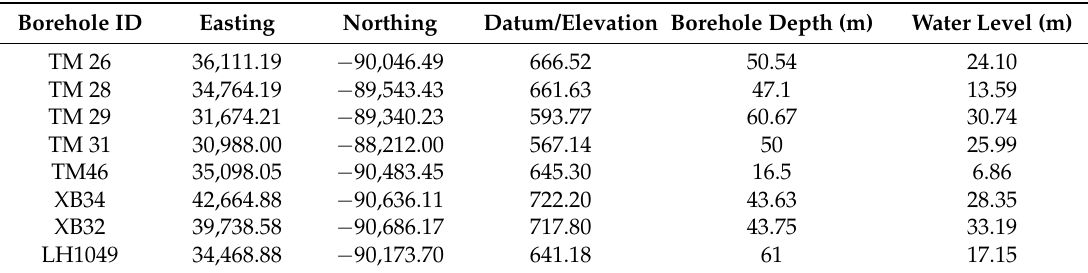
Table 1. Geographic location and depth of